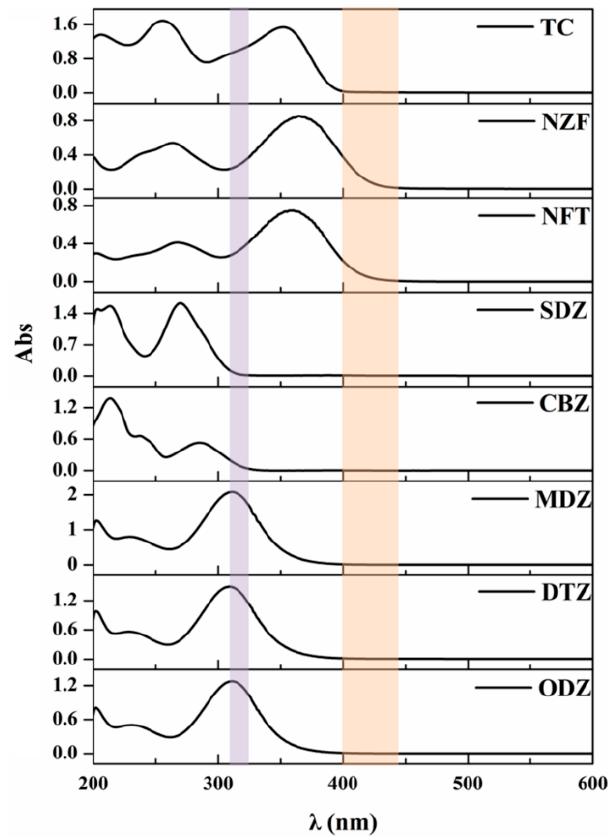
Figure 4. UV-vis spectra of eight frequently-used antibiotics.